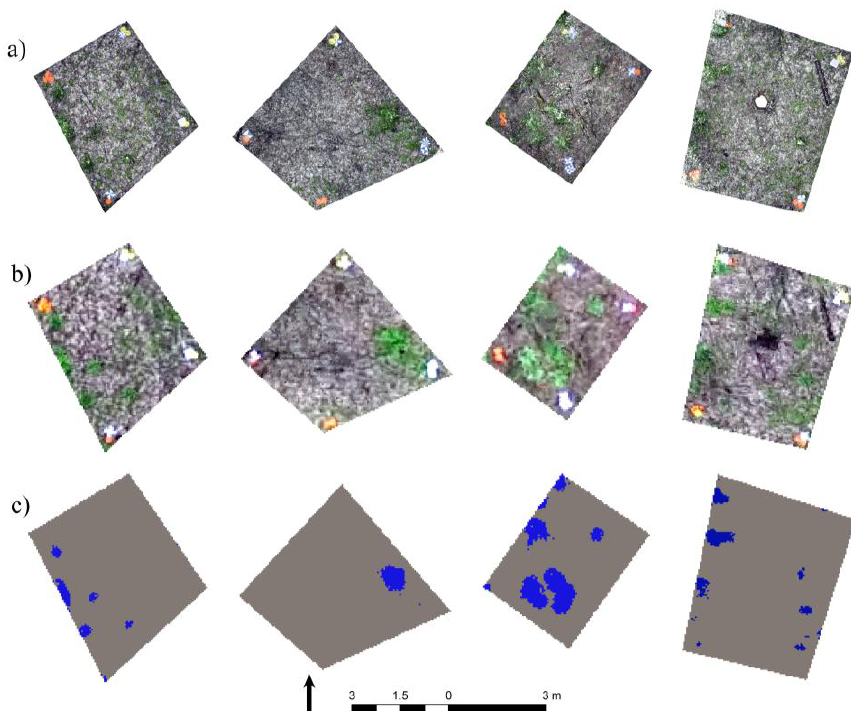
Figure 6. Comparison of ( a ) 1-cm resolution orthomosaics produced from a smartphone and used for validation, ( b ) 5-cm resolution orthomosaics produced from UAV video frames, and ( c ) classification of wild leek (blue) based on the GCC threshold, for four corners of Area 2.